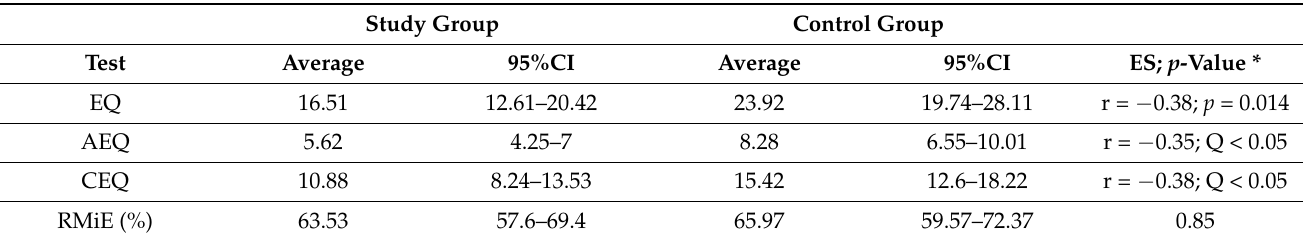
Table 2. Comparison of the parameters of questionnaire survey results in the study and control groups; * Mann–Whitney U test: ES = effect